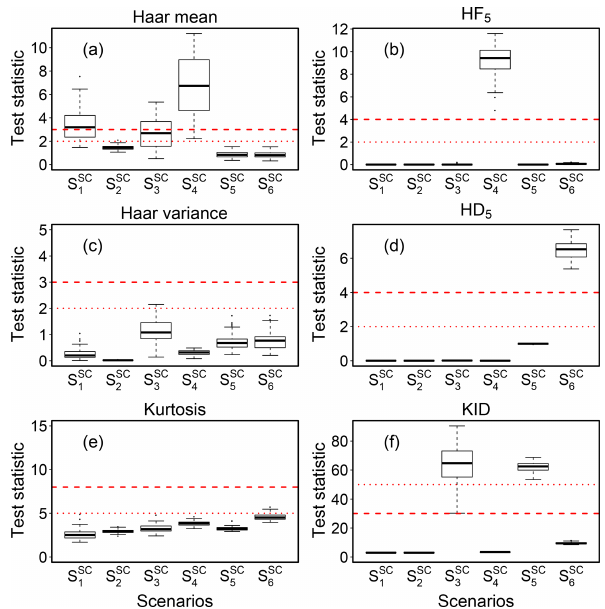
Figure 6. Distribution of results for the structural change detection tests in the S SC scenarios described in Sect. 3.1.2. Horizontal i = 1 ,..., 6 short and long dashed red lines indicate the threshold values adopted for defining SevEr and ModEr statements (hard and soft flag for VM97 tests),